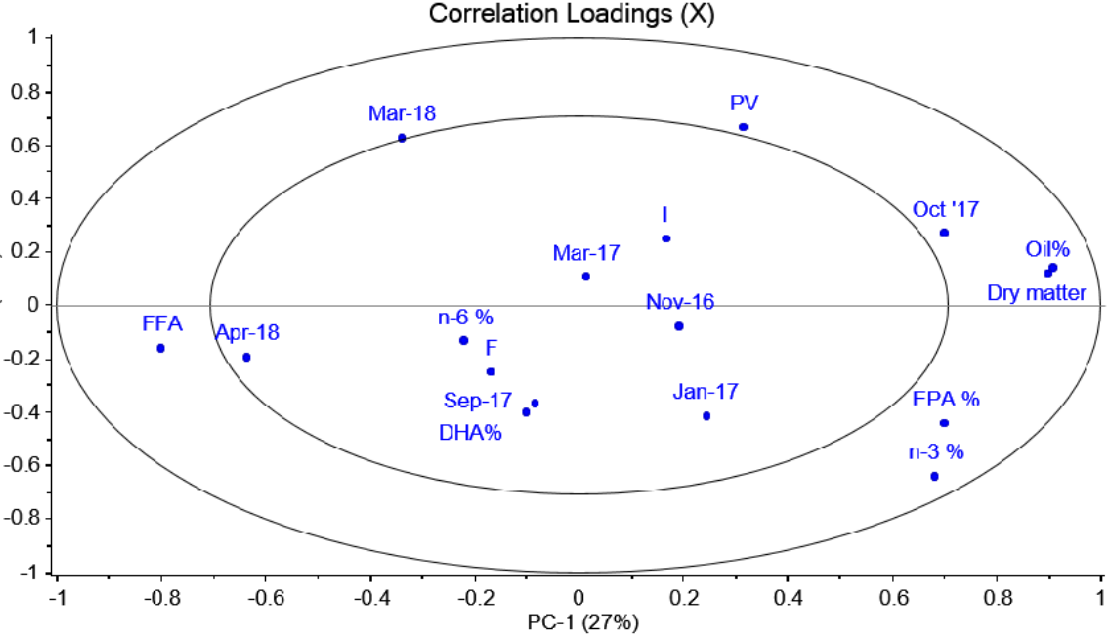
Figure A3. Loadings plot from PCA of cod samples and their oil content, dry matter, total n-3 PUFA %, total n-6 PUFA %, EPA %, DHA %, PV, FFA and information on storage conditions and sampling time. I Ice storage, F Frozen